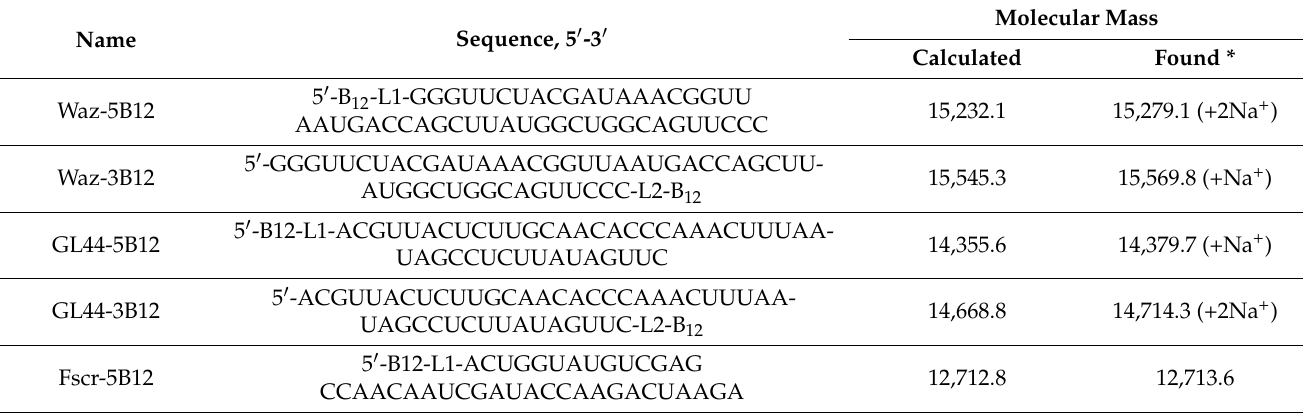
Table 1. Conjugates of 2 (cid:48) -F RNA with closo -dodecaborate attached at the 3 (cid:48) - or 5 (cid:48)